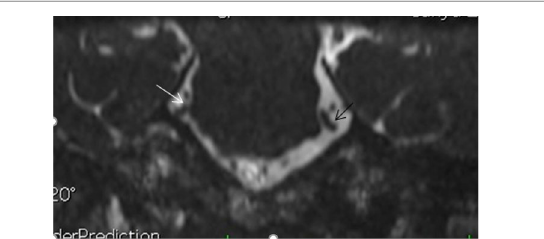
Fig. 8 Coronal FIESTA showing thinning of the trigeminal nerve on the right side (white arrow) and normal trigeminal nerve on the left side (black